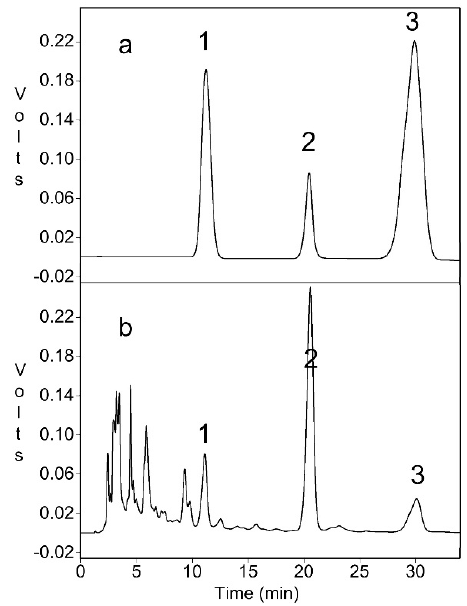
Figure 3. HPLC Chromatograms for CPT, HCPT, and VCS ‐ LT standards ( a ) and extract from C. acuminata fruits ( b ). Peak 1 for CPT, Peak 2 for HCPT, Peak 3 for VCS ‐